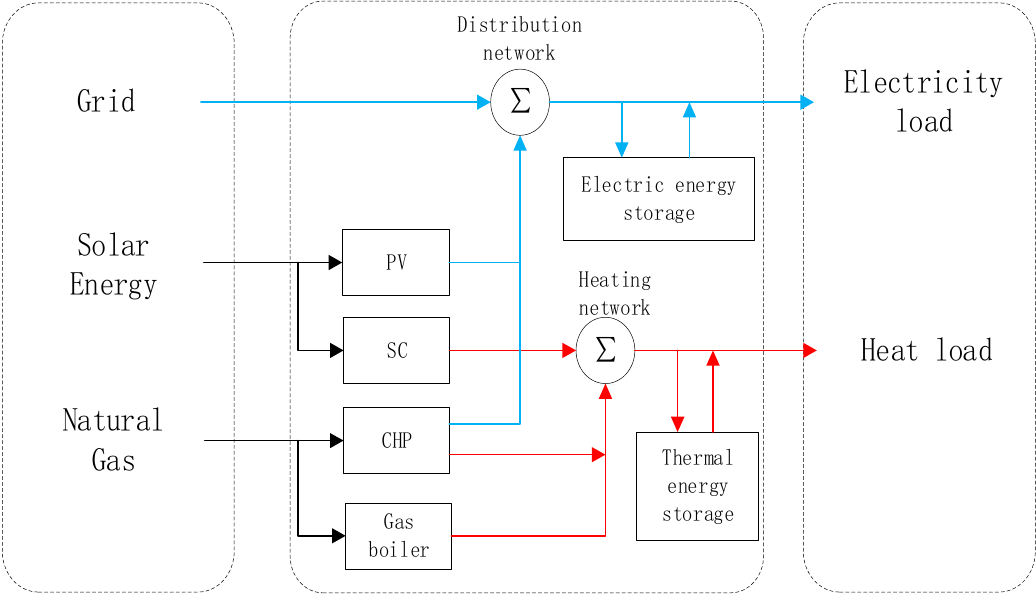
Figure 1. Schematic diagram of a district integrated energy system.